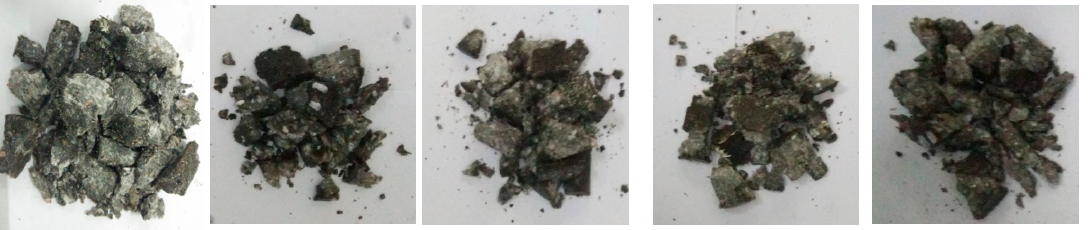
Figure 11. Failure phenomenon under different impact velocities and equivalent aging time.